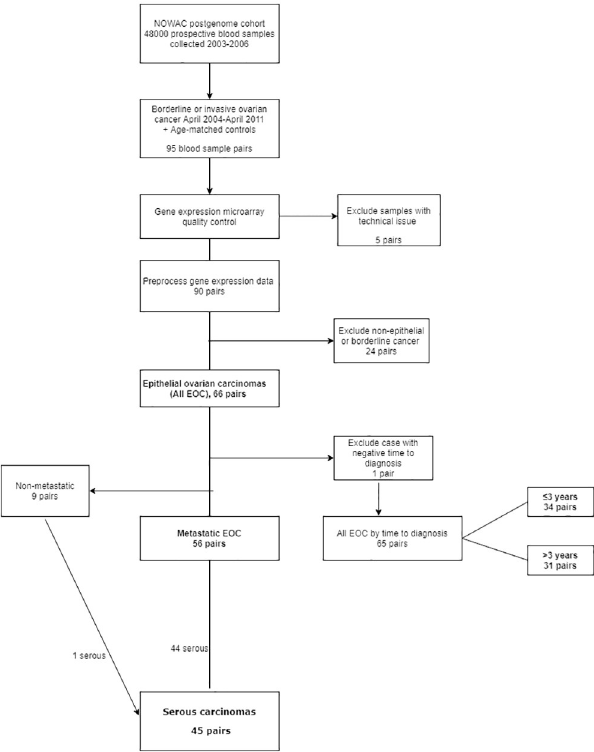
Fig 1. Flow chart of exclusions and analytic groups in gene expression analyses. Bold text indicates analyzed groups. The group “All EOC by time to diagnosis” was used in the analysis of all EOC adjusted for leukocyte populations.